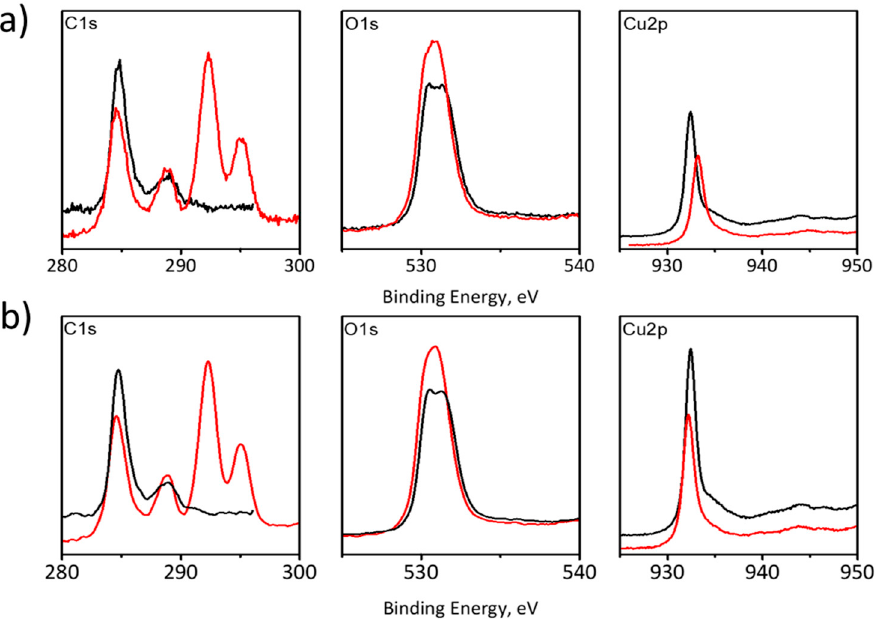
Figure 6. XPS analysis of Cu-electrode before (black curve) and after (red curve) tests in ( a ) 1 M KHCO 3 and ( b ) 1 M KHCO 3 + C 6 H 10 CuO 6 .